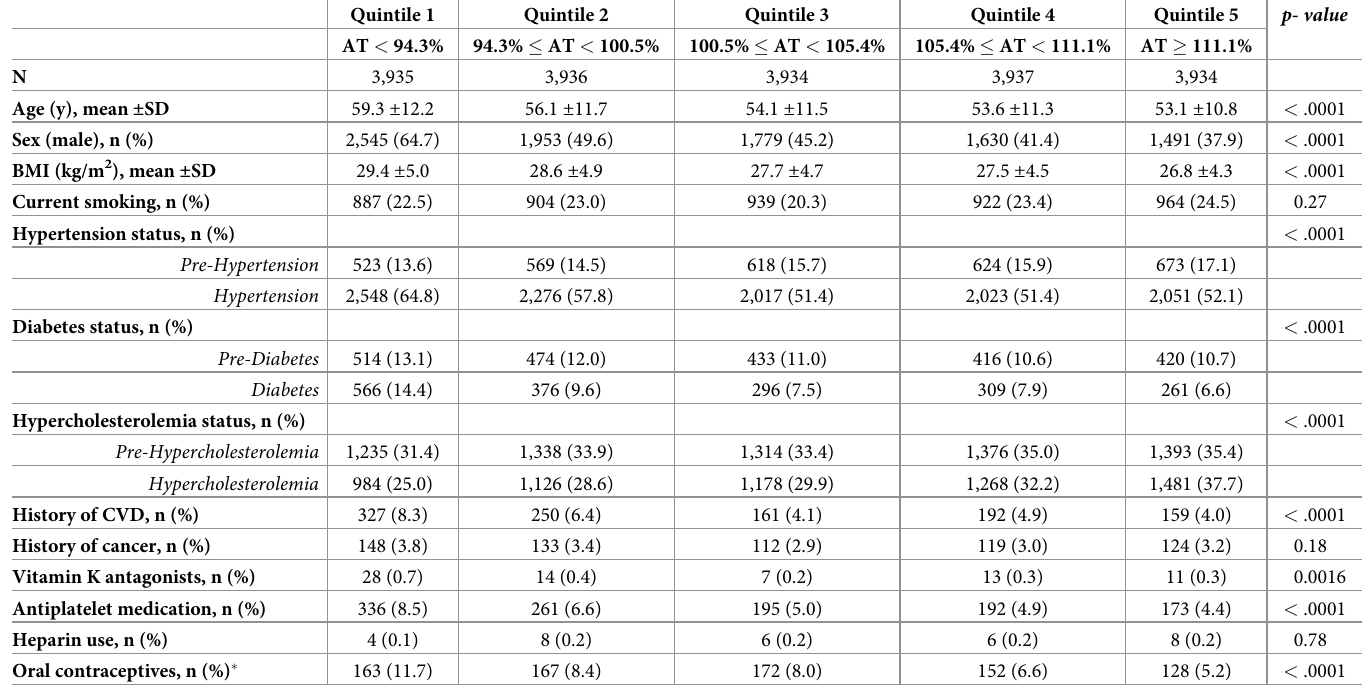
Table 1. Baseline characteristics according to quintiles of AT in the Moli-sani